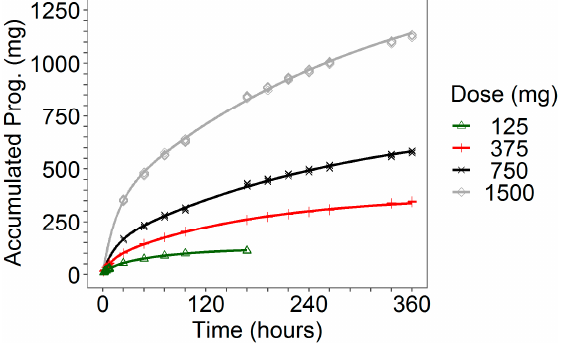
Figure 3. Observed in vitro individual data and fitted cumulative release profiles for all dose lev- els.